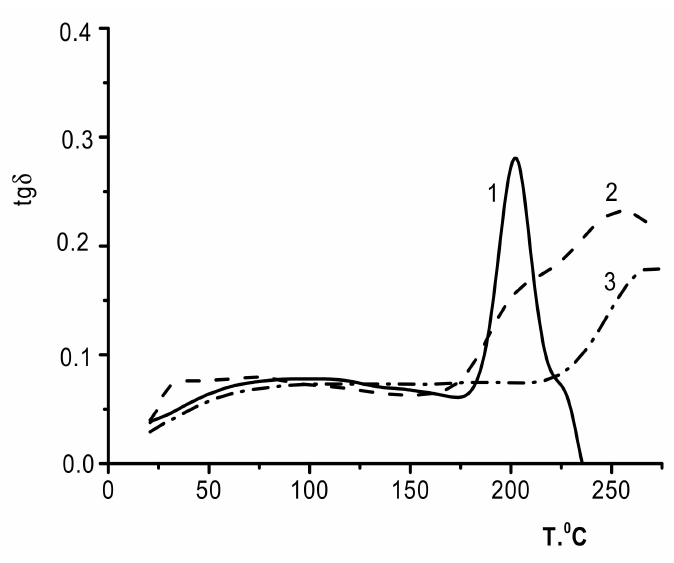
Figure 7. Temperature dependence of the mechanical loss tangent: 1, HA; 2, CS b –PEC HA ; and 3, CS b